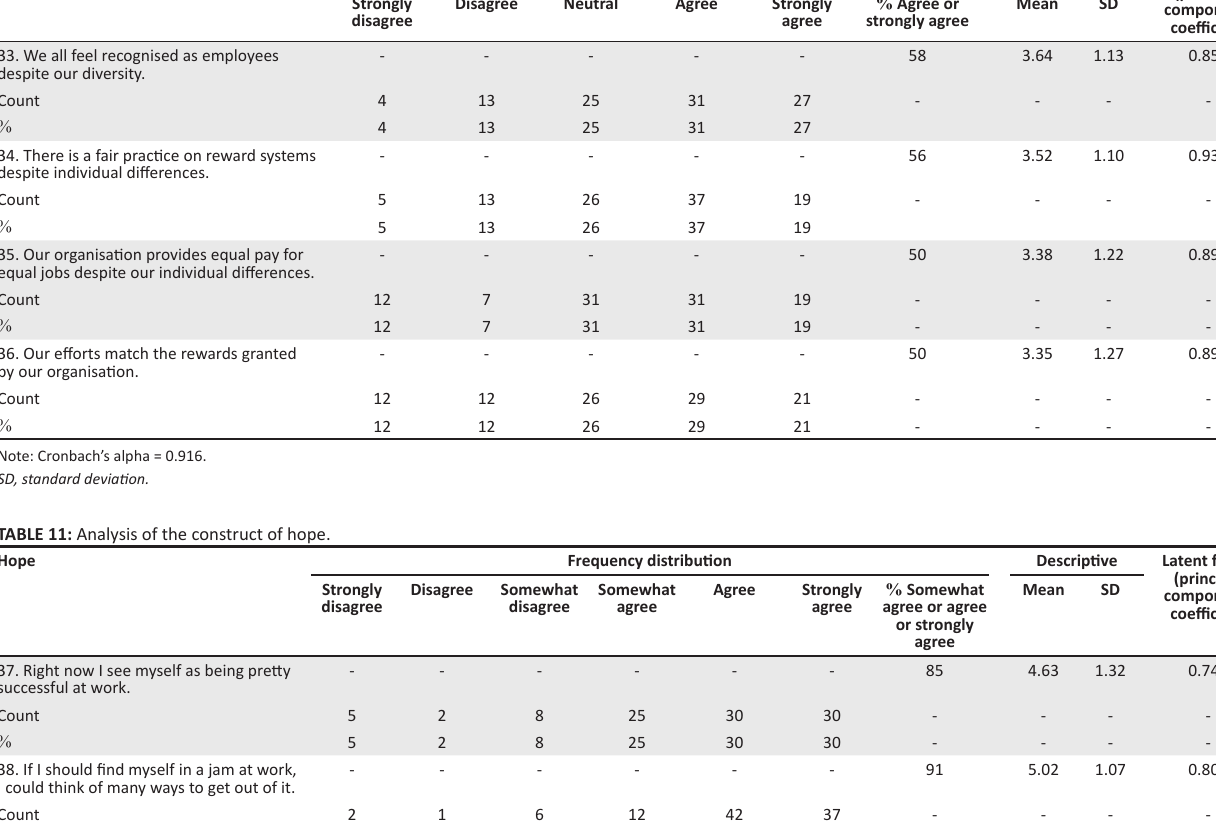
TABLE 10: Analysis of the construct of reward and compensation. Reward and compensation